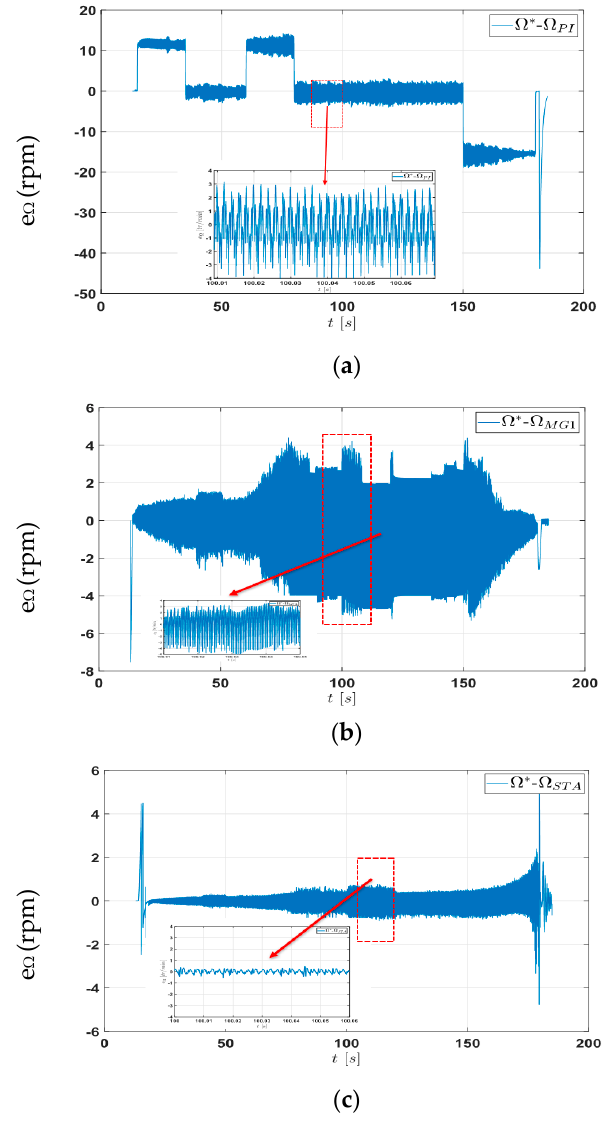
Figure 14. Zoom on the velocity responses in steady state.